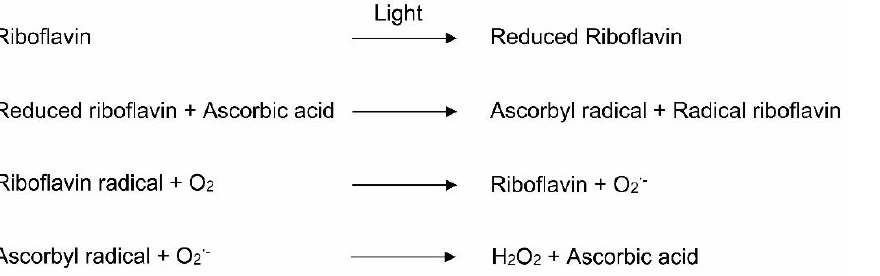
Figure 4. Generation of peroxides in the TPN in the presence of riboflavin and vitamin C. O 2•− , superoxide radical; H 2 O 2 , hydrogen peroxide.